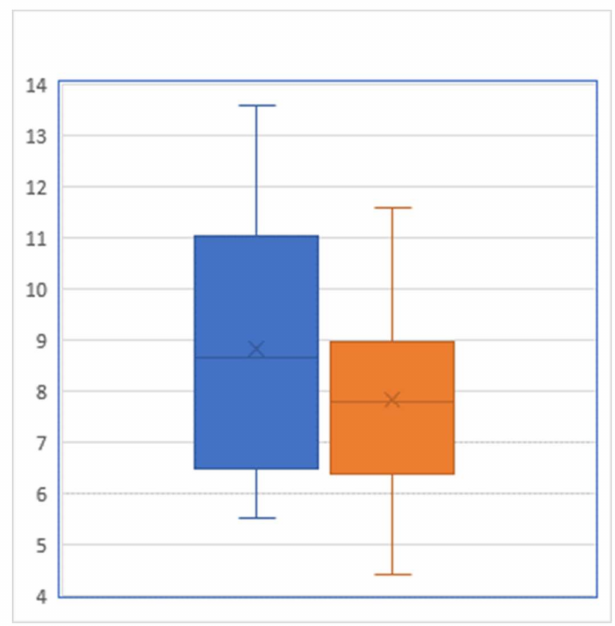
Figure 1. Box-and-whisker plot of hemoglobin A1C level (percent) before (left) and after (right) the intervention (Sample size = 29).